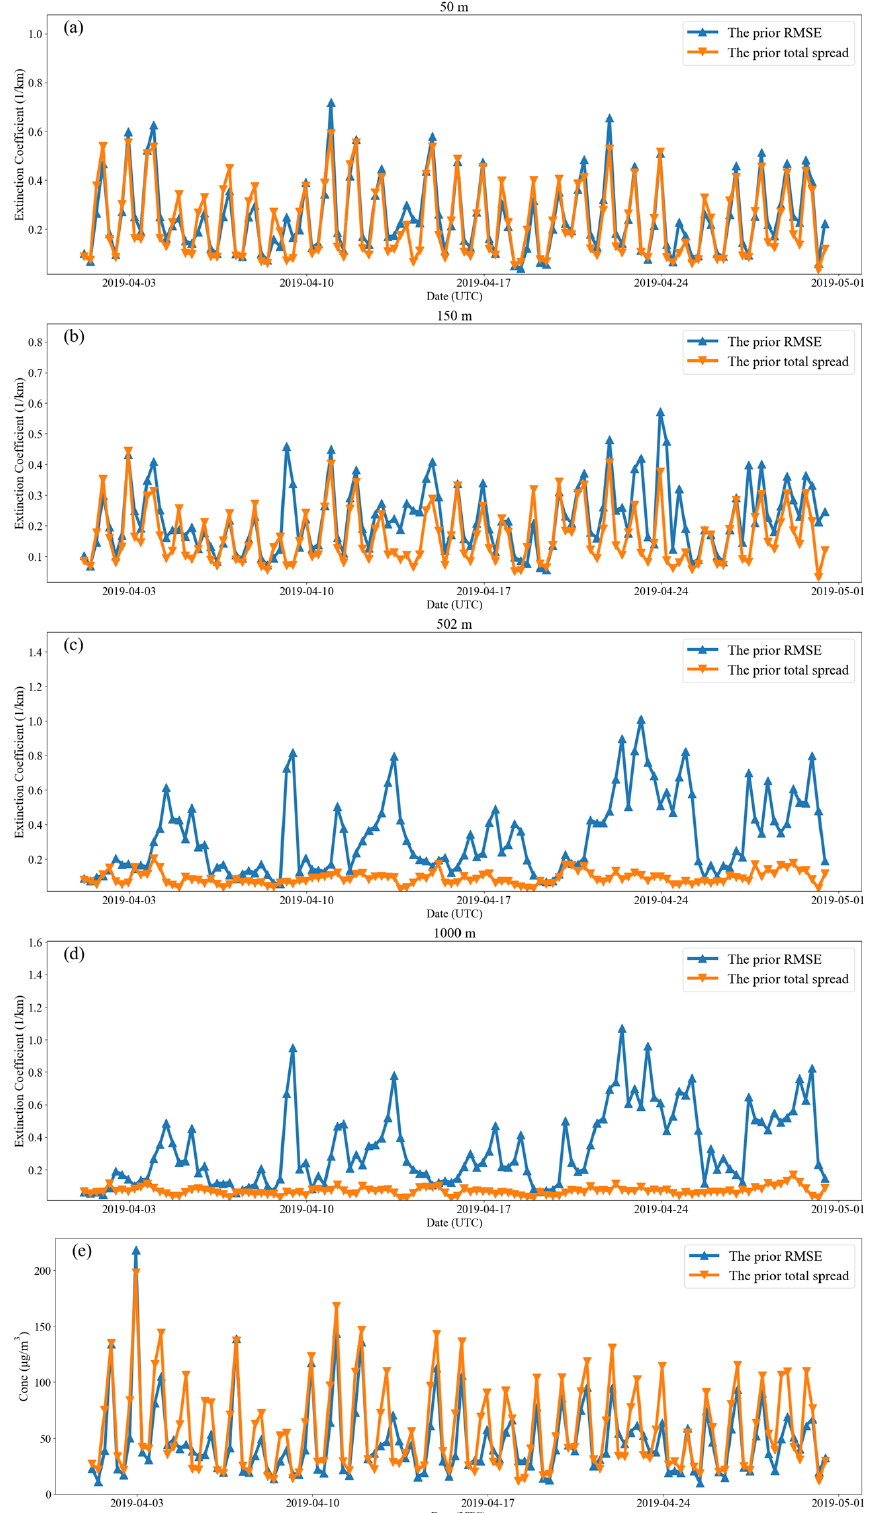
Figure 7. Time series of prior RMSE and total spread over all observations for (a) extinction coefficients at 50m, (b) extinction coefficients at 150m, (c) extinction coefficients at 502m, (d) extinction coefficients at 1000m, and (e) the surface PM 2 . 5 .